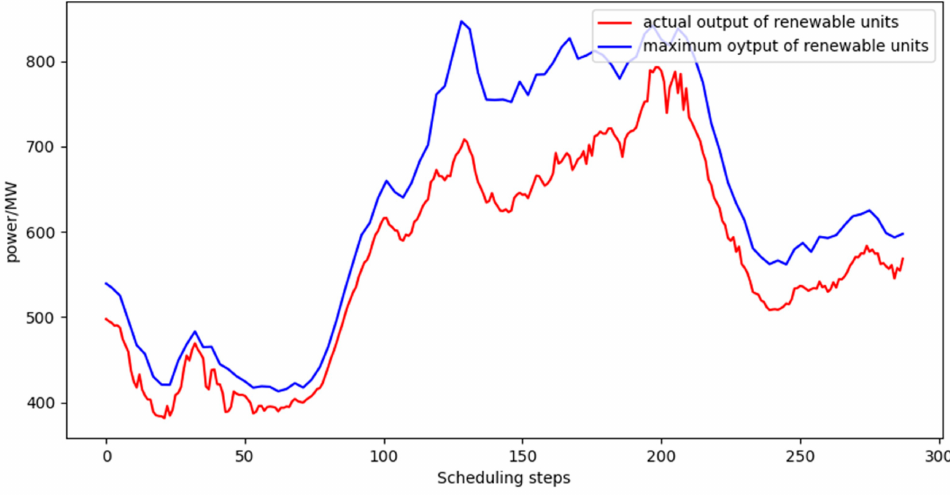
Figure 8. The scheduling period with a large proportion of the maximum renewable energy